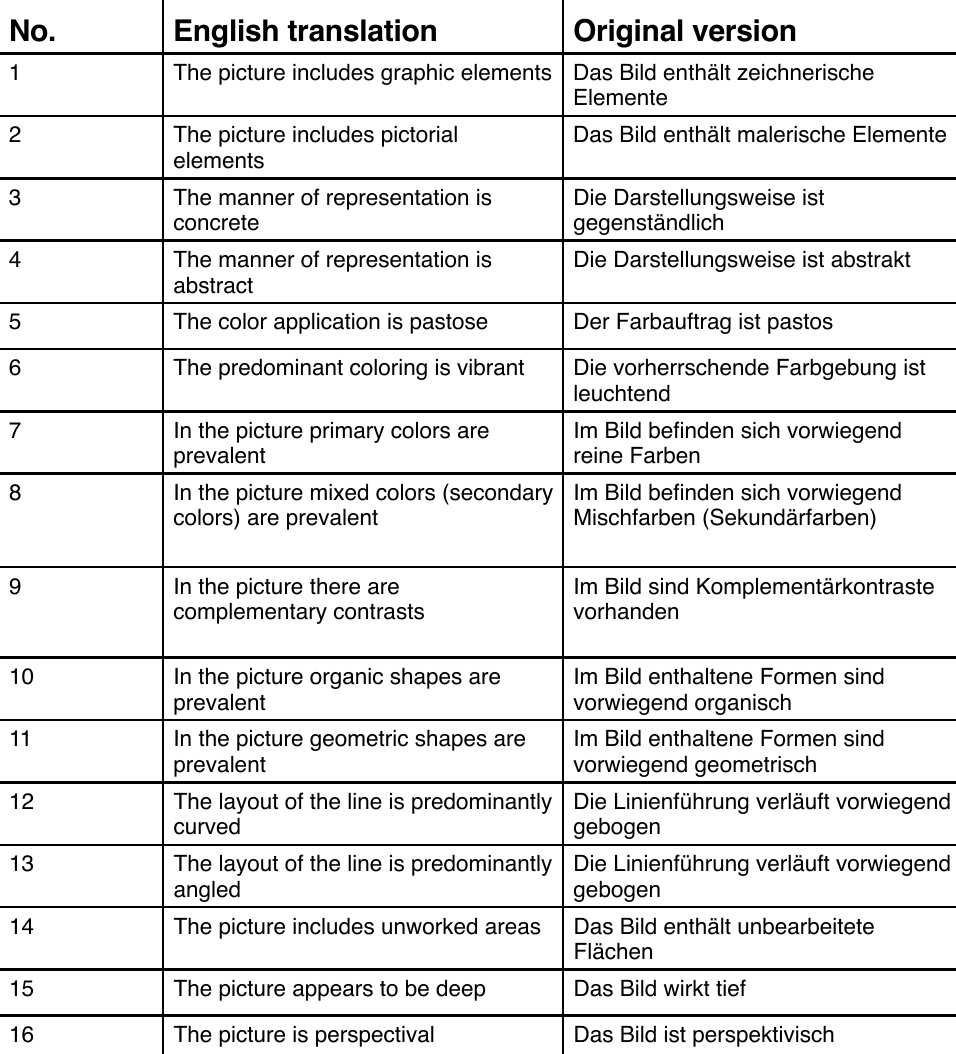
RizbA items: English translation and original German